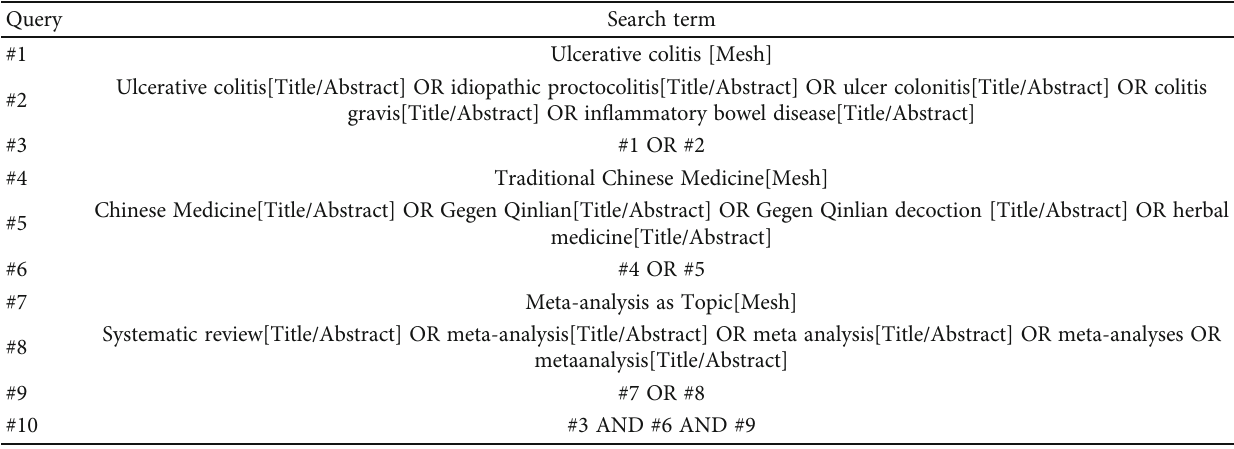
Table 1: Search strategy for the PubMed